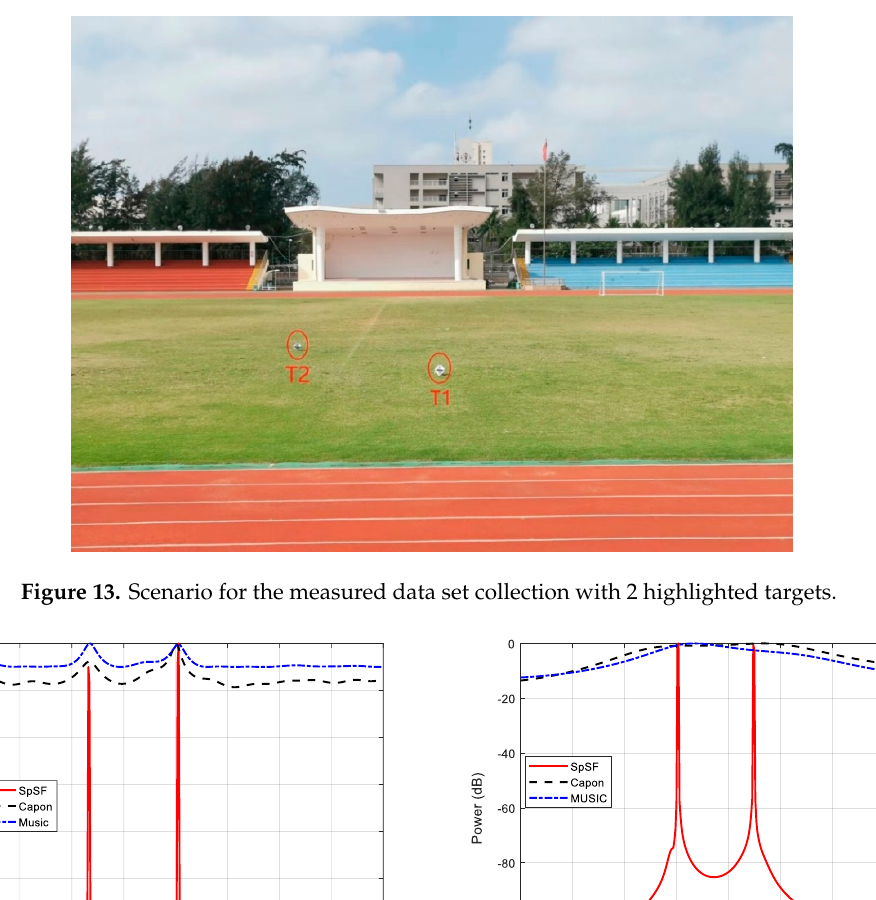
Figure 12. Range estimation of the real data.